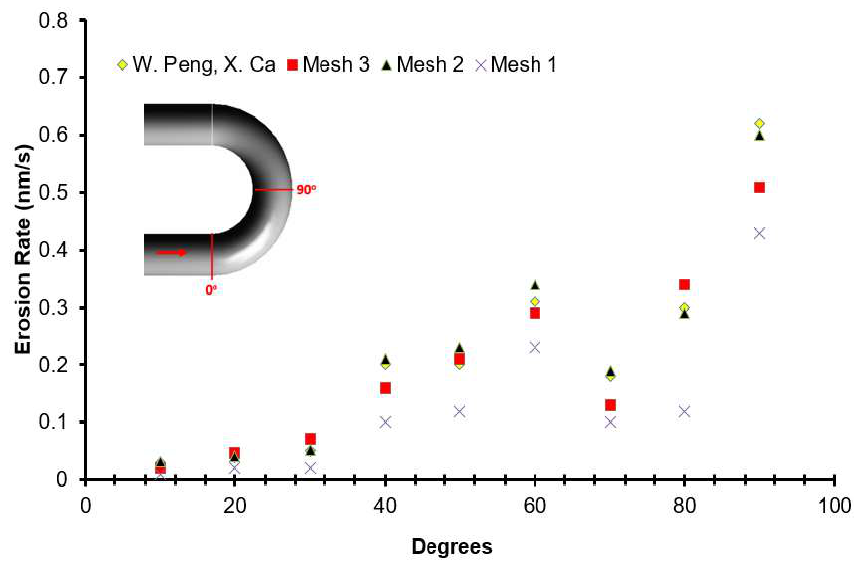
Figure 3. Comparison of the erosion rate obtained with three different mesh sizes and numerical results in W. Peng, X. Ca [27]. Table 1. Summary of simulation cases.